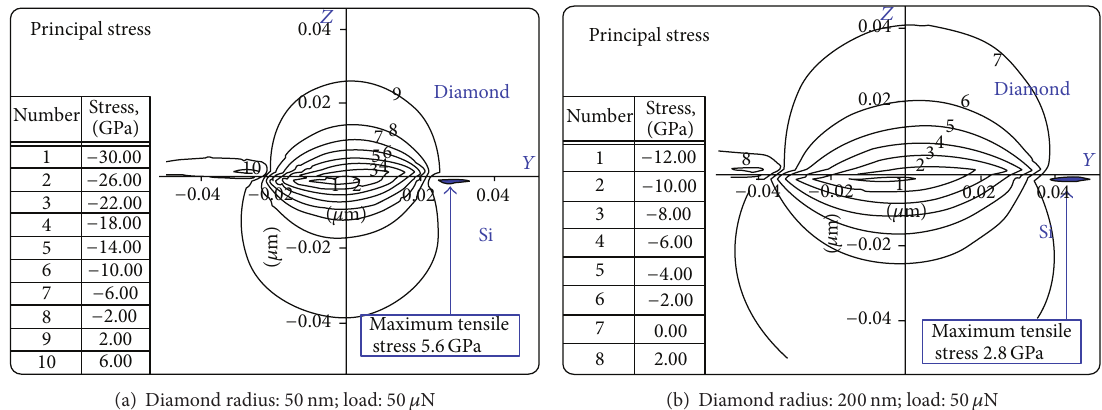
Figure 6: Principal stress of the silicon-diamond contact area at 50 𝜇 N load for tip radii of (a) 50 and (b) 200 nm.